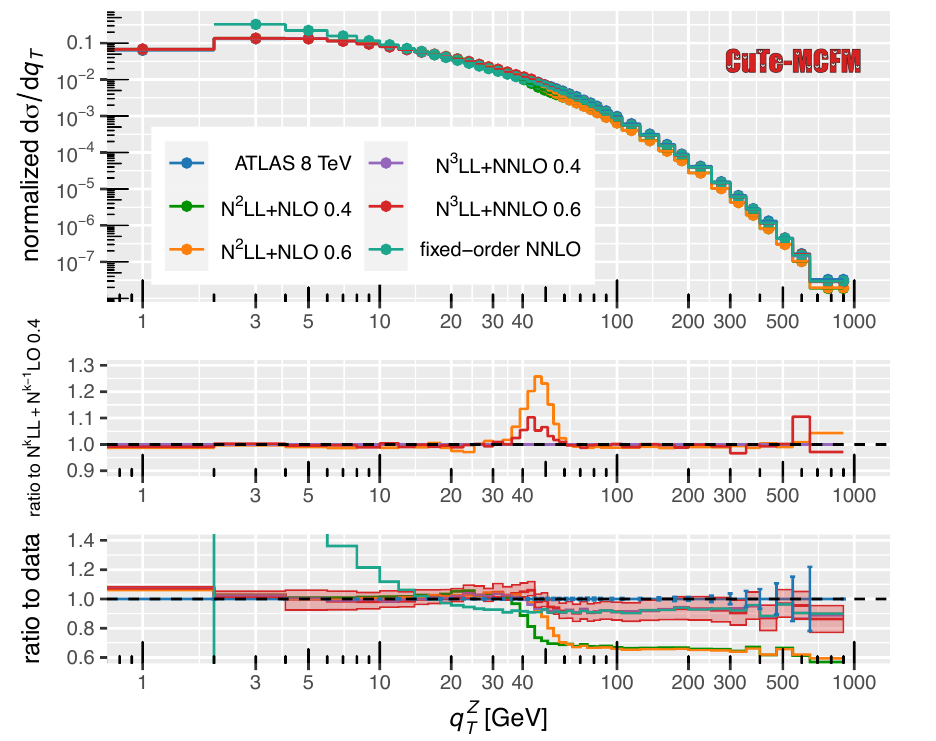
Figure 7. Predicted and measured normalized transverse-momentum distribution of the Z boson with fiducial cuts as in the ATLAS study at 8 TeV in ref. [99]. The middle panel shows the effect of varying the transition function, while the bottom panel shows the ratio to data with estimated scale